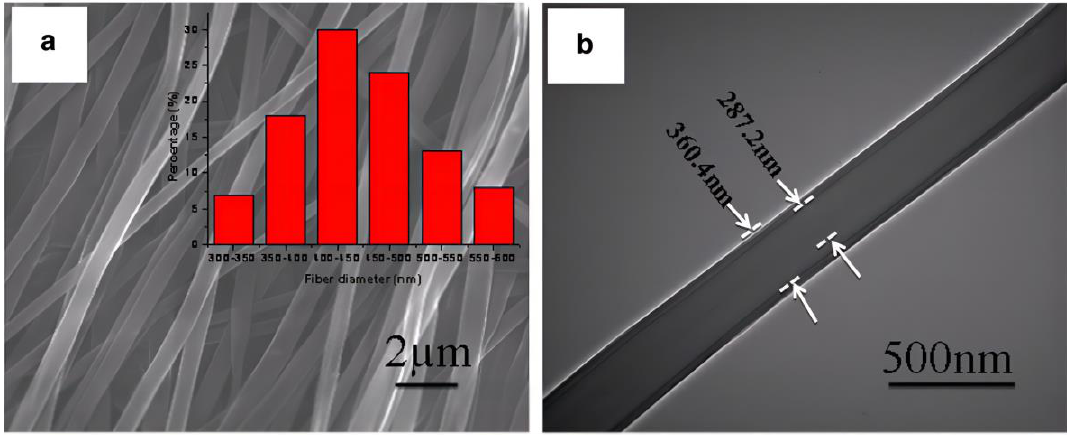
Figure 12. ( a ) SEM- and ( b )TEM-micrographs of PAN-PMMA core-shell nanofibers. Images from [23].